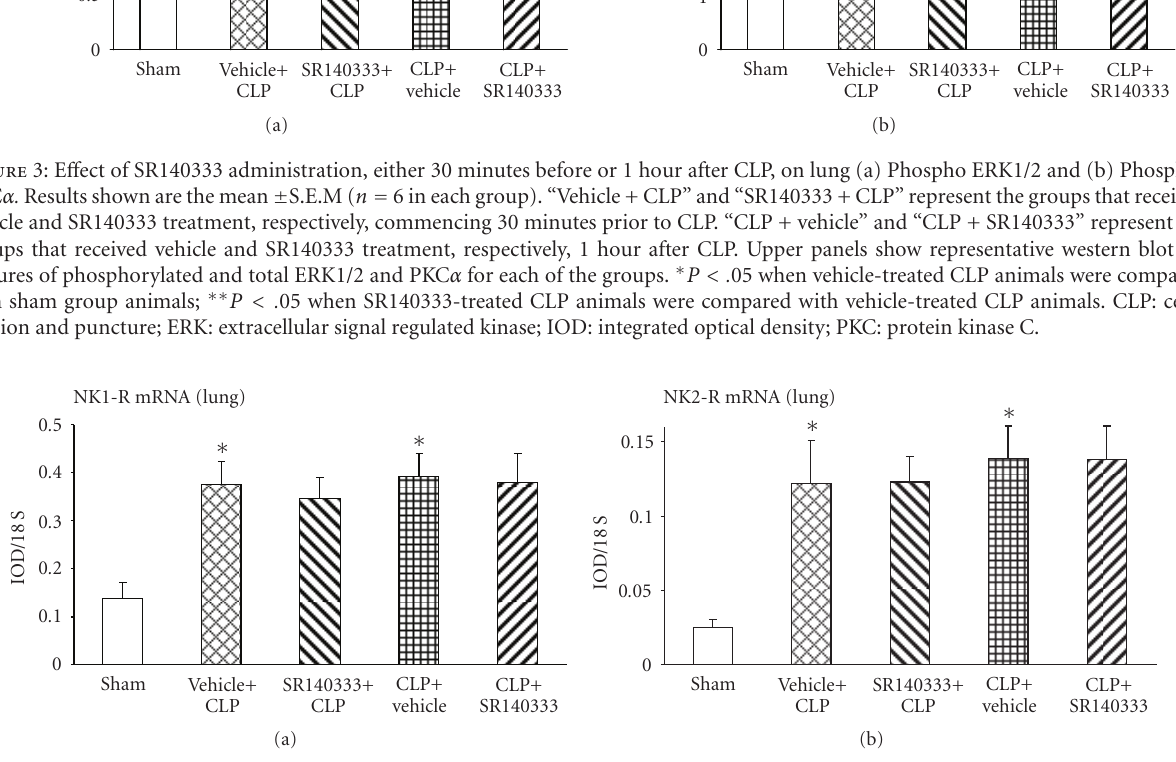
Figure 4: E ff ect of SR140333 administration, either 30 minutes before or 1 hour after CLP, on lung (a) NK-1R and (b) NK-2R mRNA levels. Results shown are the mean ± S.E.M ( n = 6–9 in each group). “Vehicle + CLP” and “SR140333 + CLP” represent the groups that received vehicle and SR140333 treatment, respectively, commencing 30 minutes prior to CLP. “CLP + vehicle” and “CLP + SR140333” represent the groups that received vehicle and SR140333 treatment, respectively, 1 hour after CLP. ∗ P < . 05 when vehicle-treated CLP animals were compared with sham group animals. CLP: cecal ligation and puncture; IOD: integrated optical density; NK-1(2)R: neurokinin-1(2) receptor.